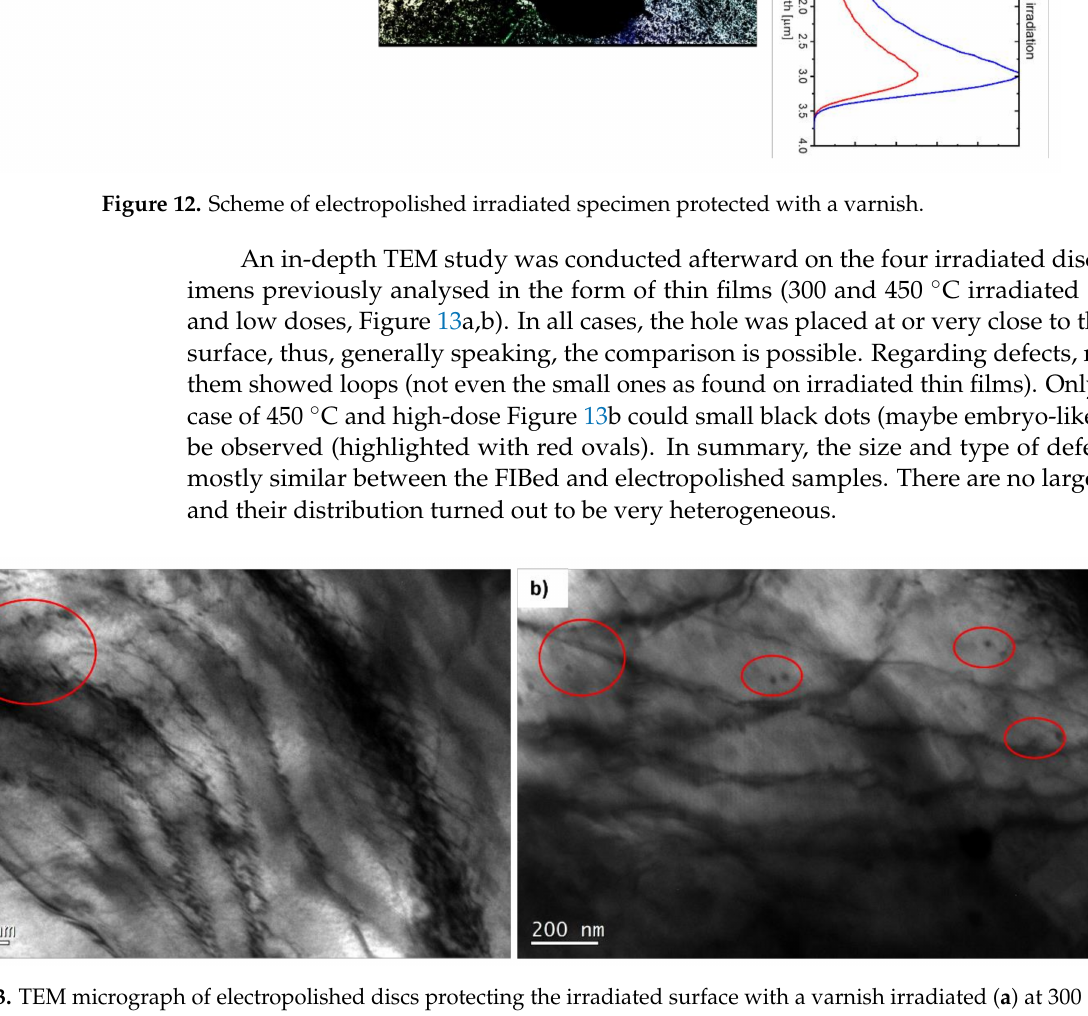
Figure 13. TEM micrograph of electropolished discs protecting the irradiated surface with a varnish irradiated ( a ) at 300 ◦ C and low dose and ( b ) at 450 ◦ C and high dose. Some of the defects detected in the microstructure are highlighted with red